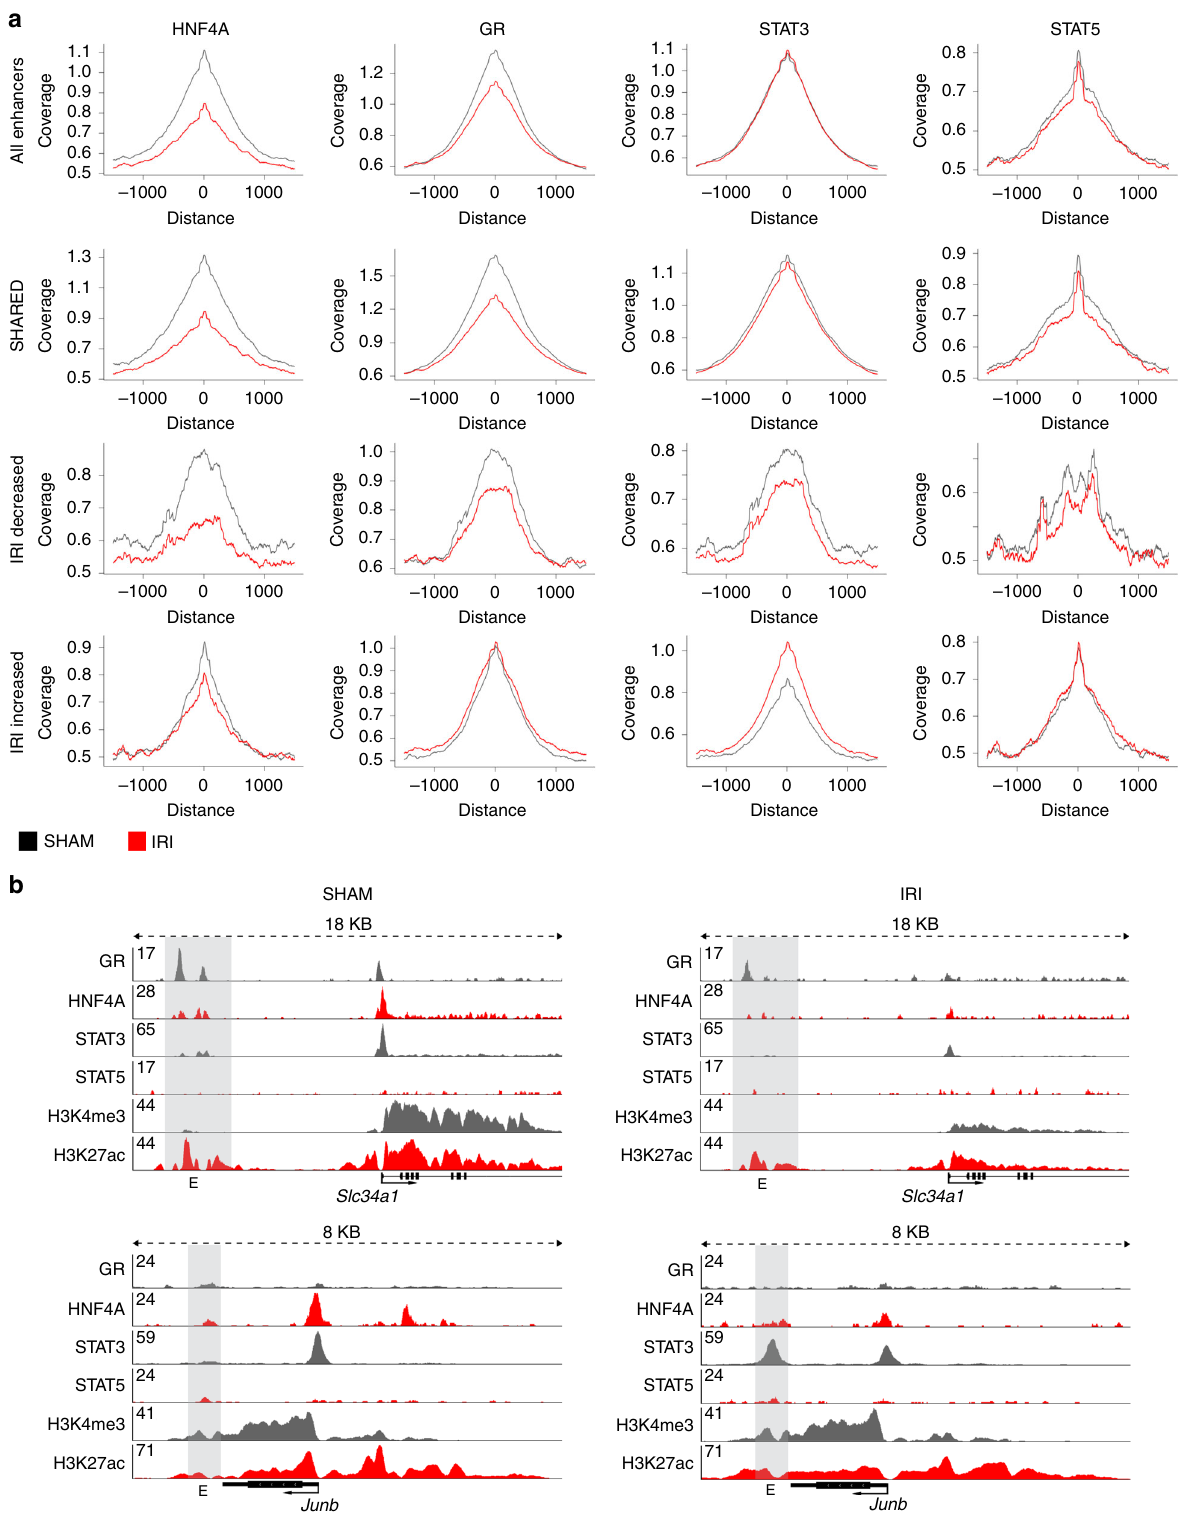
Fig. 4 HNF4A, GR, STAT3, and STAT5 binding at enhancer elements. a Genome-wide coverage plots at all, SHARED, IRI-decreased and IRI-increased enhancers. The coverage for HNF4A and GR decreased in SHARED and IRI-decreased enhancer group after IRI. In contrast, STAT3 shows increased coverage at IRI-increased enhancers. STAT5 peak height at enhancer elements is unchanged after kidney injury. b Representative examples of transcription factor binding at enhancer sites in kidney epithelia cells. The Slc34a1 and Junb genomic locus are shown for HNF4A, GR, STAT3, and STAT5 binding together with H3K4me3 and H3K27ac in the SHAM (left) and IRI (right) condition. Enhancer elements are indicated by gray